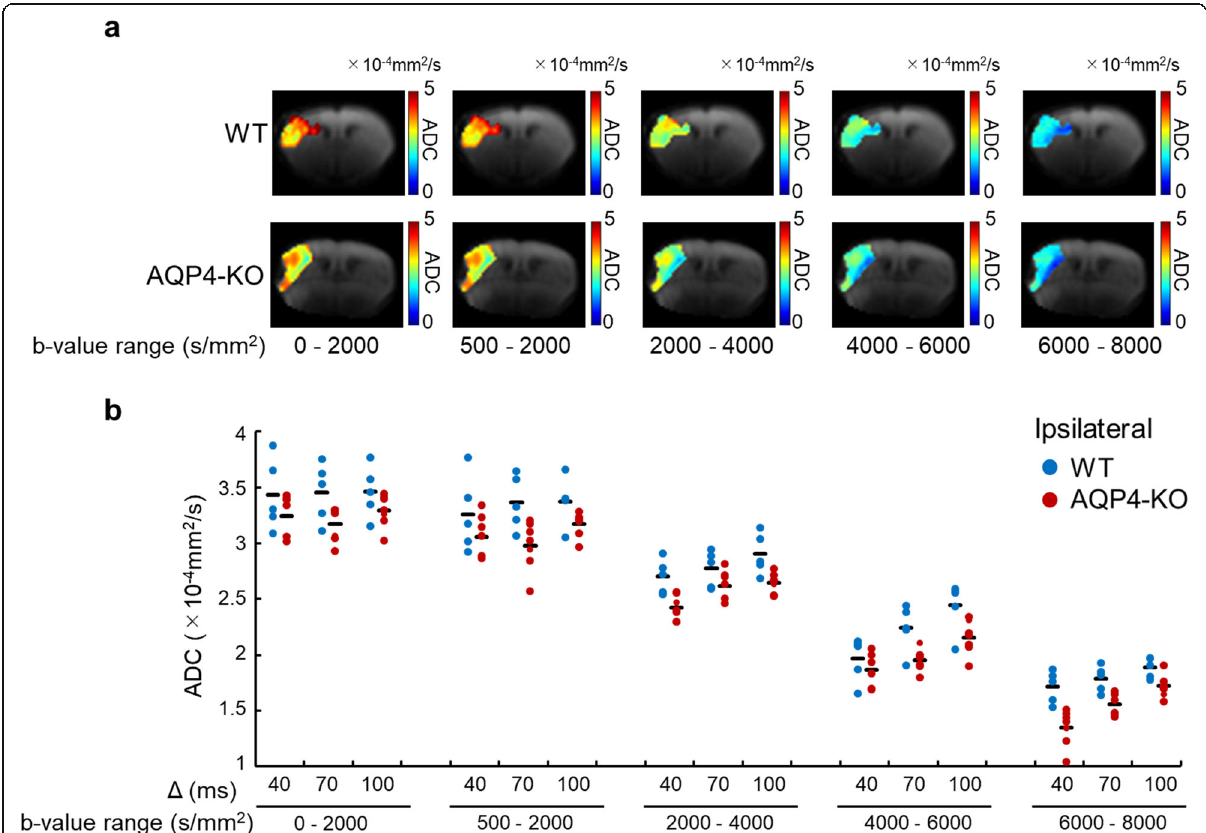
Fig. 2 Apparent diffusion coefficient (ADC) in the ischemic region. Typical ADC maps of wild-type (WT) (top) and aquaporin-4 knockout (AQP4- KO) mice (top and bottom, respectively) focused on the ipsilateral region at Δ = 70 ms ( a ). The ADC in the ischemic region has a range of 0 – 5 × 10 − 4 mm 2 /s. The plots show the mean ADC of each WT (blue) and AQP4-KO (red) mouse for each b -value range and Δ ( b ). The black bars correspond to the mean over animals. The results of the statistical analysis are shown in Table